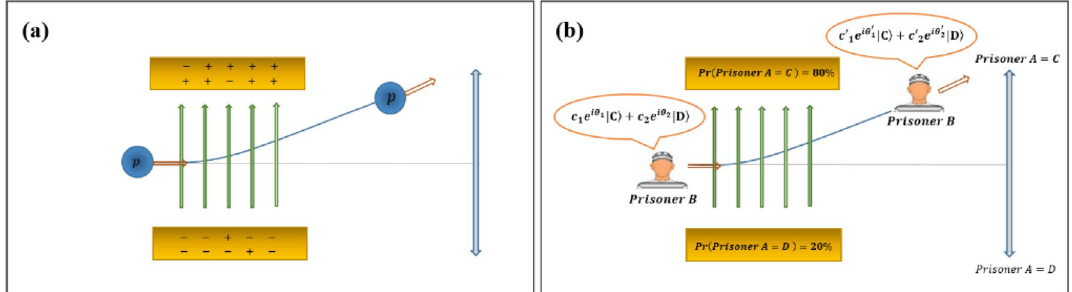
Figure 3. ( a ) The deviation of the proton p under the influence of the electric field, created due to the unequal percentage of positive charges in the plates under the classical view, ( b ) The deviation of the initial superposition state including phase parameters in the human mind of the second prisoner (under unequal probabilities of defection and cooperation of the first prisoner) due to considering a hypothetical bias field under the quantum- like view.